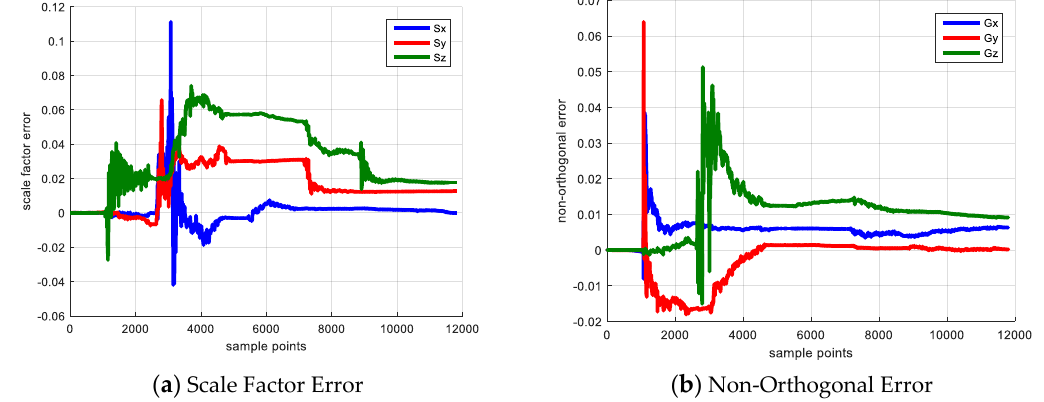
Figure 5. Sensor Error Estimation.